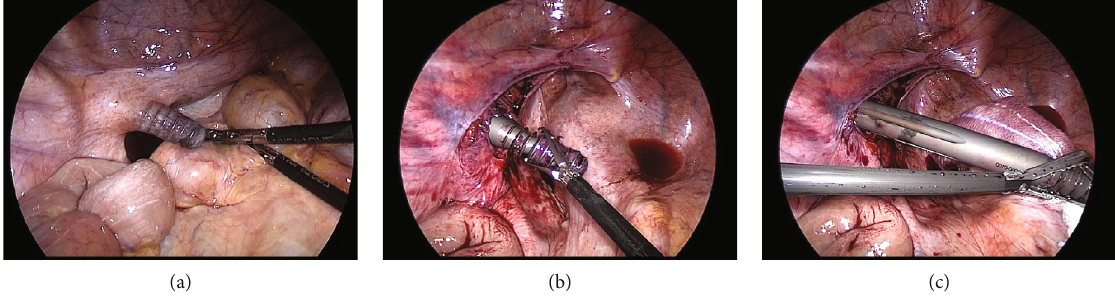
Figure 5: Laparoscopic views showing the lag screw, intestine, and peritoneum: (a) damage to the intestine was not observed; (b) the peritoneum around the lag screw was peeled; (c) the lag screw was pulled out with forceps.